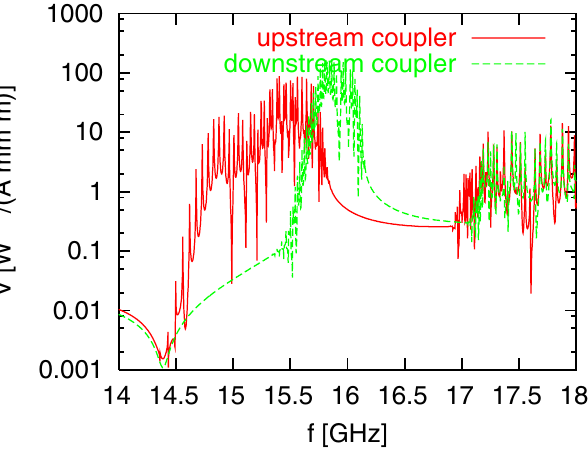
FIG. 9. (Color) Simulated output signals from upstream and downstream monitors versus frequency.